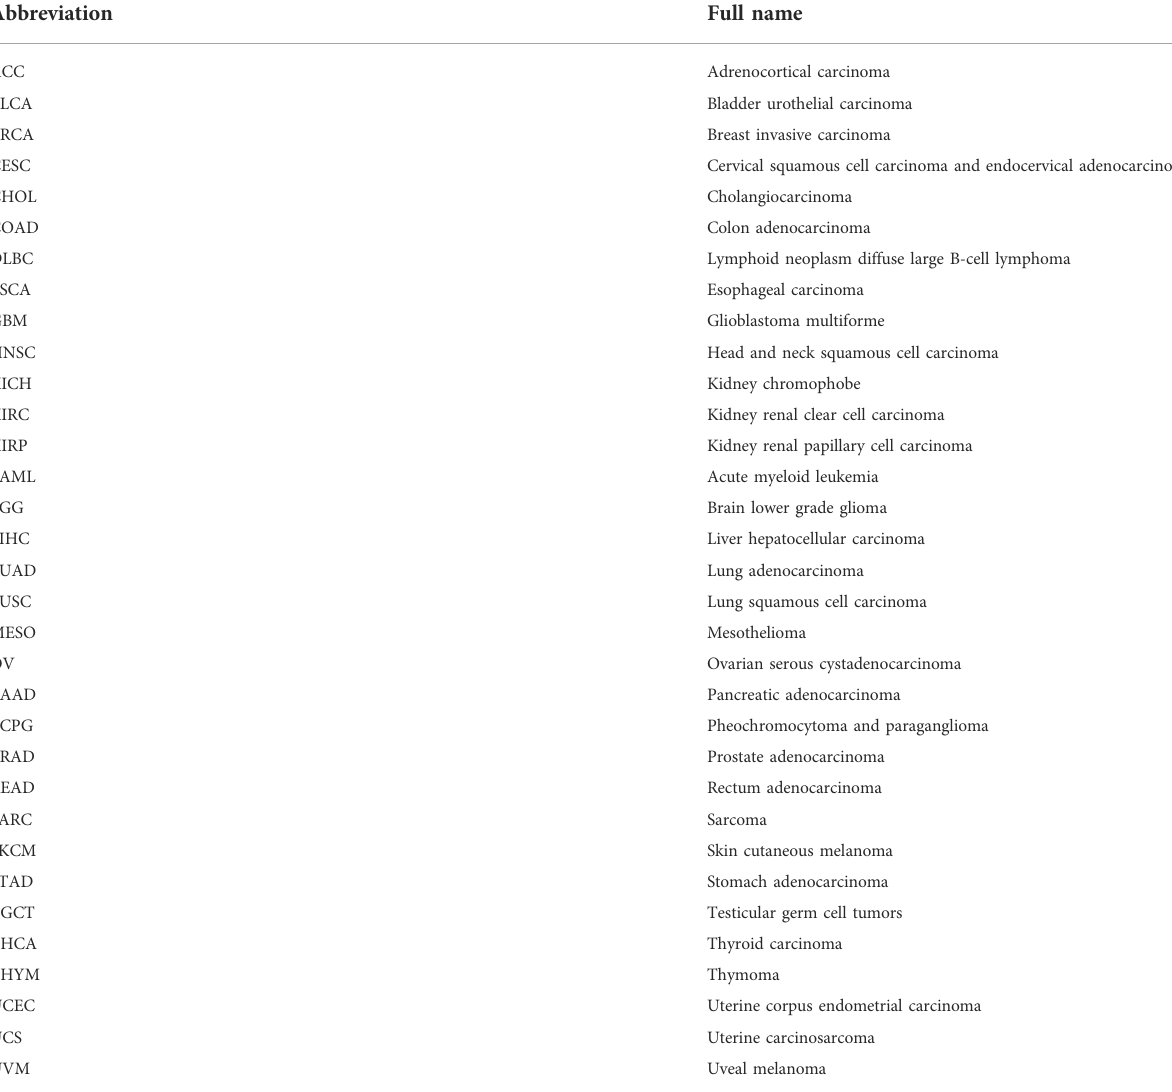
TABLE 1 Abbreviation of 33 human